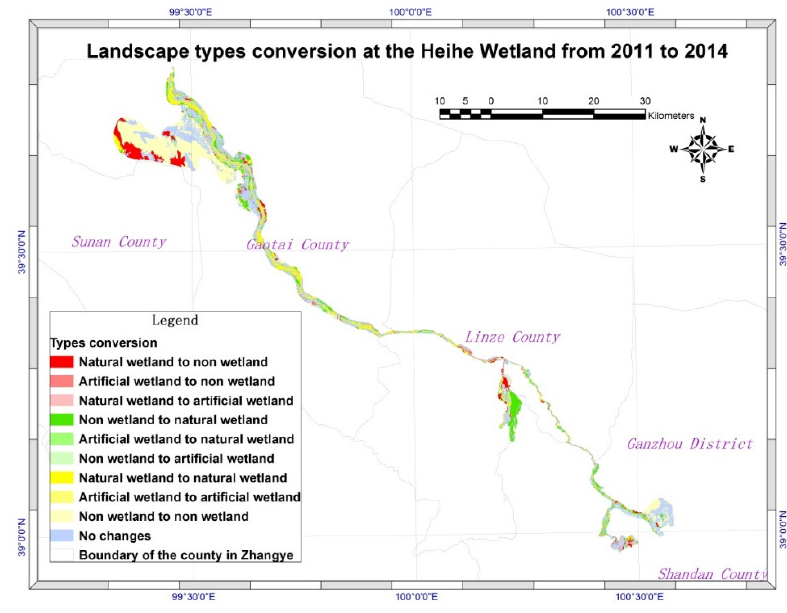
Figure 6. Transition of landscape types during 2011–2014 in the Heihe wetlands. The legend in the figure shows the conversion of different landscape